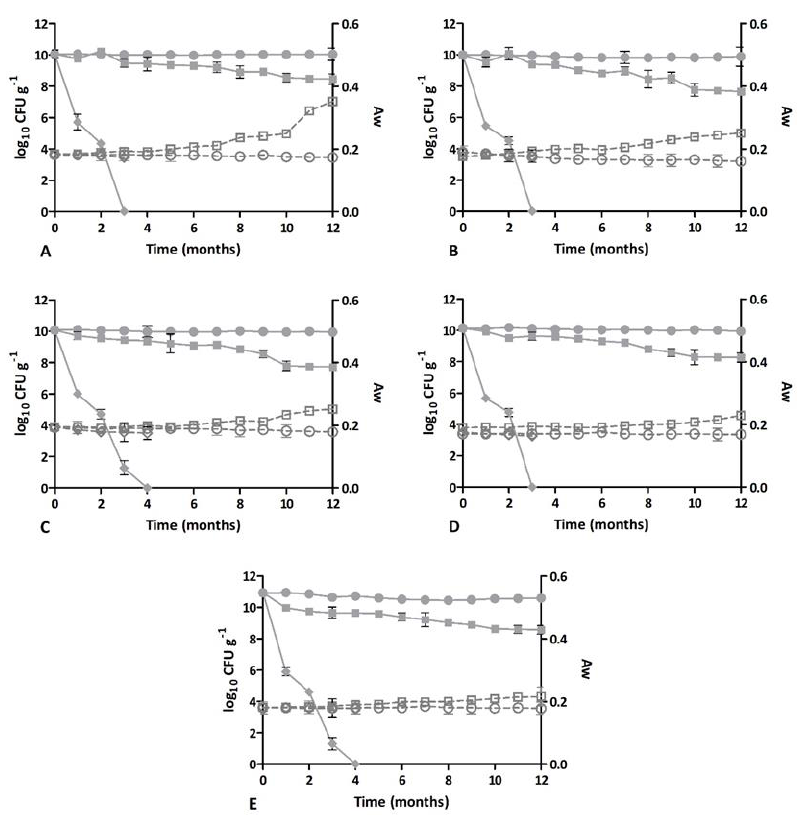
Figure 2. Trend over time of the bacterial count (expressed as log 10 CFU capsule − 1 (full sign)) and water activity (Aw—empty sign) of lyophilized SYNBIO ® powder combined with several elderberry extracts (elderberry extract at 6.5% ( A ), 10% ( B ), and 13% ( C ), elderberry flower and leaf extract at 0.3% ( D ), and elderberry fruit extract ( E )) and stored at different temperatures (+4 °C ( ○ ), +25 °C (□), and +40 °C (◊)).